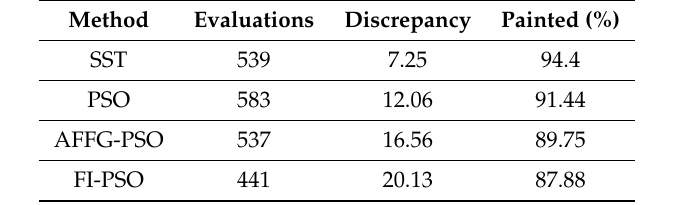
Table 2. “Paint” Evolutionary Approximation results.